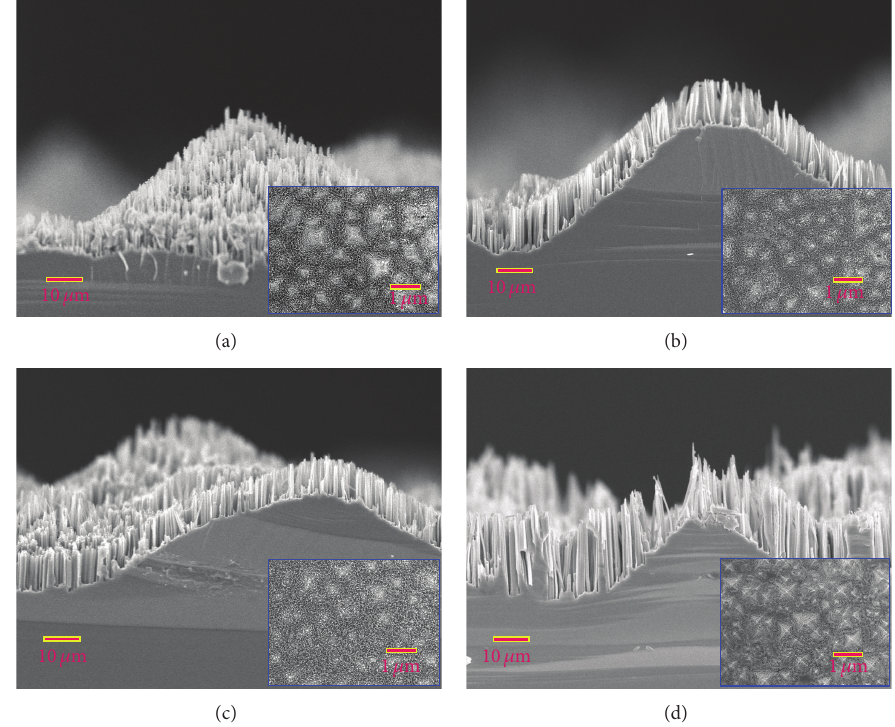
Figure 1: SEM images of micronanohybrid silicon substrates fabricated by combinations of a fixed first-stage processing time (30sec) and various second-stage processing times: (a) 1 min, (b) 2 min, (c) 3 min, and (d) 4 min.